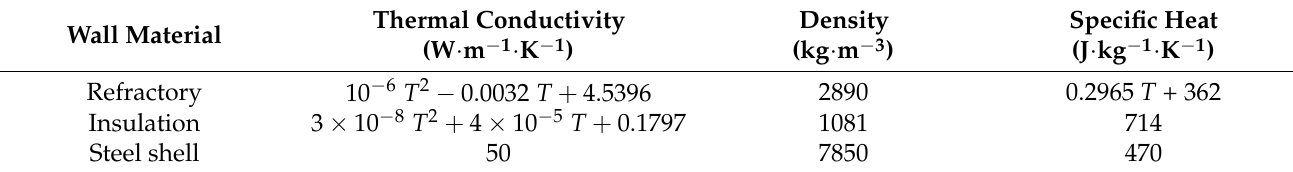
25 Table 6. Operating conditions for solid product with input gases preheated to 1000 °C. Feed